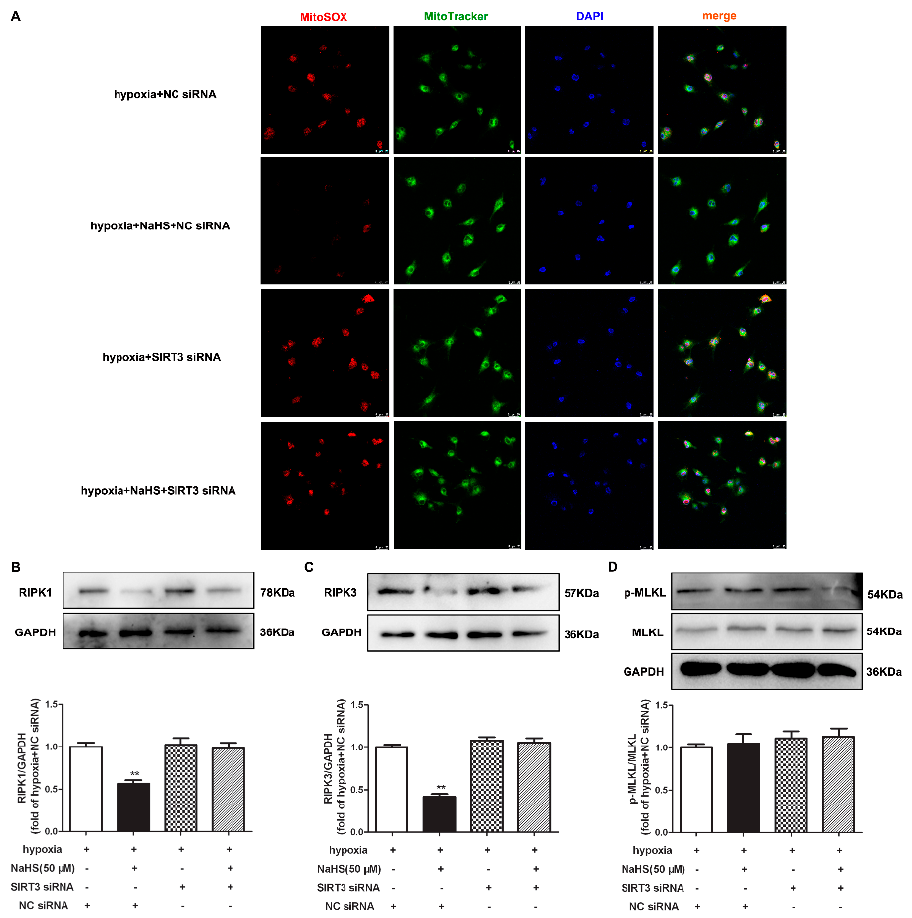
Figure 9. NaHS failed to alleviate mitochondrial oxidative stress and attenuate necroptosis after SIRT3 knockdown in cardiac fibroblasts with hypoxia. After transfection by SIRT3 siRNA or NC siRNA for 48 h, neonatal rat cardiac fibroblasts were pre-administrated with NaHS (50 µ M) for 4 h followed by incubation with normoxia (containing 5% CO 2 and 95% O 2 ) or hypoxia (containing 5% CO 2 and 1% O 2 ) for another 4 h. ( A ) Mitochondrial ROS production was detected by MitoSOX (red) staining, and the mitochondria were localized by MitoTracker (green) staining. The nuclei were stained with DAPI (blue). Bar = 25 µ m. ( B – D ) The RIPK1, RIPK3, and MLKL protein expressions were detected by Western blot. ** p < 0.01 vs. hypoxia-induced cells with NC siRNA transfection, n = 6.